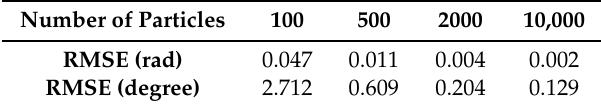
Table 1. Comparison of root mean square error (RMSE) performance depending on the number of particles. Number of Particles 100 500 2000 10,000 RMSE (rad) 0.047